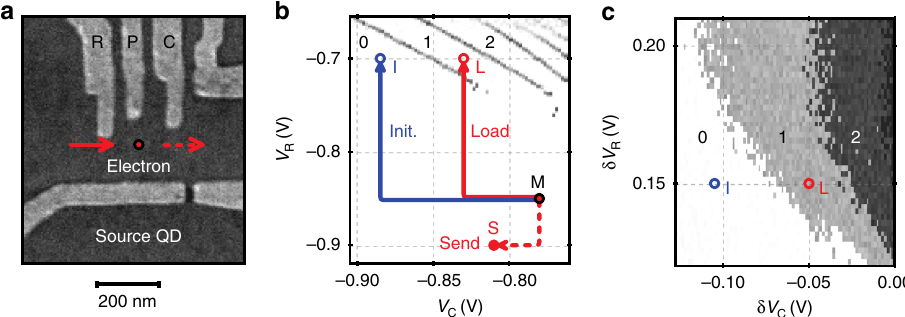
Fig. 5 Preparation of SAW-driven single-electron transfer. a SEM image of a source QD with indication of surface electrodes. b Charge-stability diagram showing example source-quantum-dot con fi gurations for QPC measurement (M), initialisation (I), single-electron loading (L) and sending (S). Here, we = ∂ V plot ∂ I . The data show abrupt jumps in QPC current indicating charge-degeneracy lines of the QD. c Loading map showing con fi gurations I and L. QPC R Each pixel represents the difference in QPC current, Δ I , before and after visiting the respective loading con fi guration. The colourscale re fl ects the QPC electron number in the QD